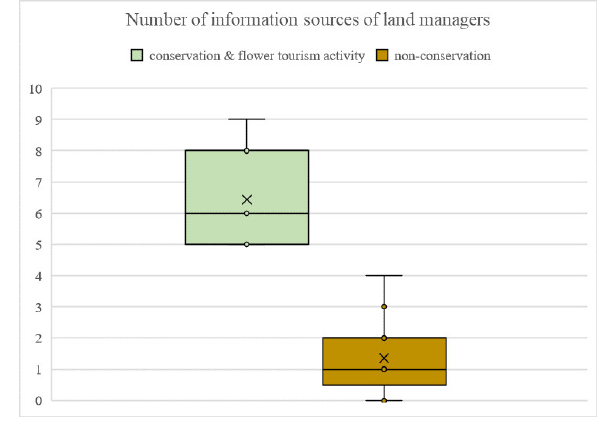
Fig. 5. Boxplots of the number of information sources for renosterveld land managers in the Swartland region involved in conservation or flower tourism activities and land managers not involved in conservation